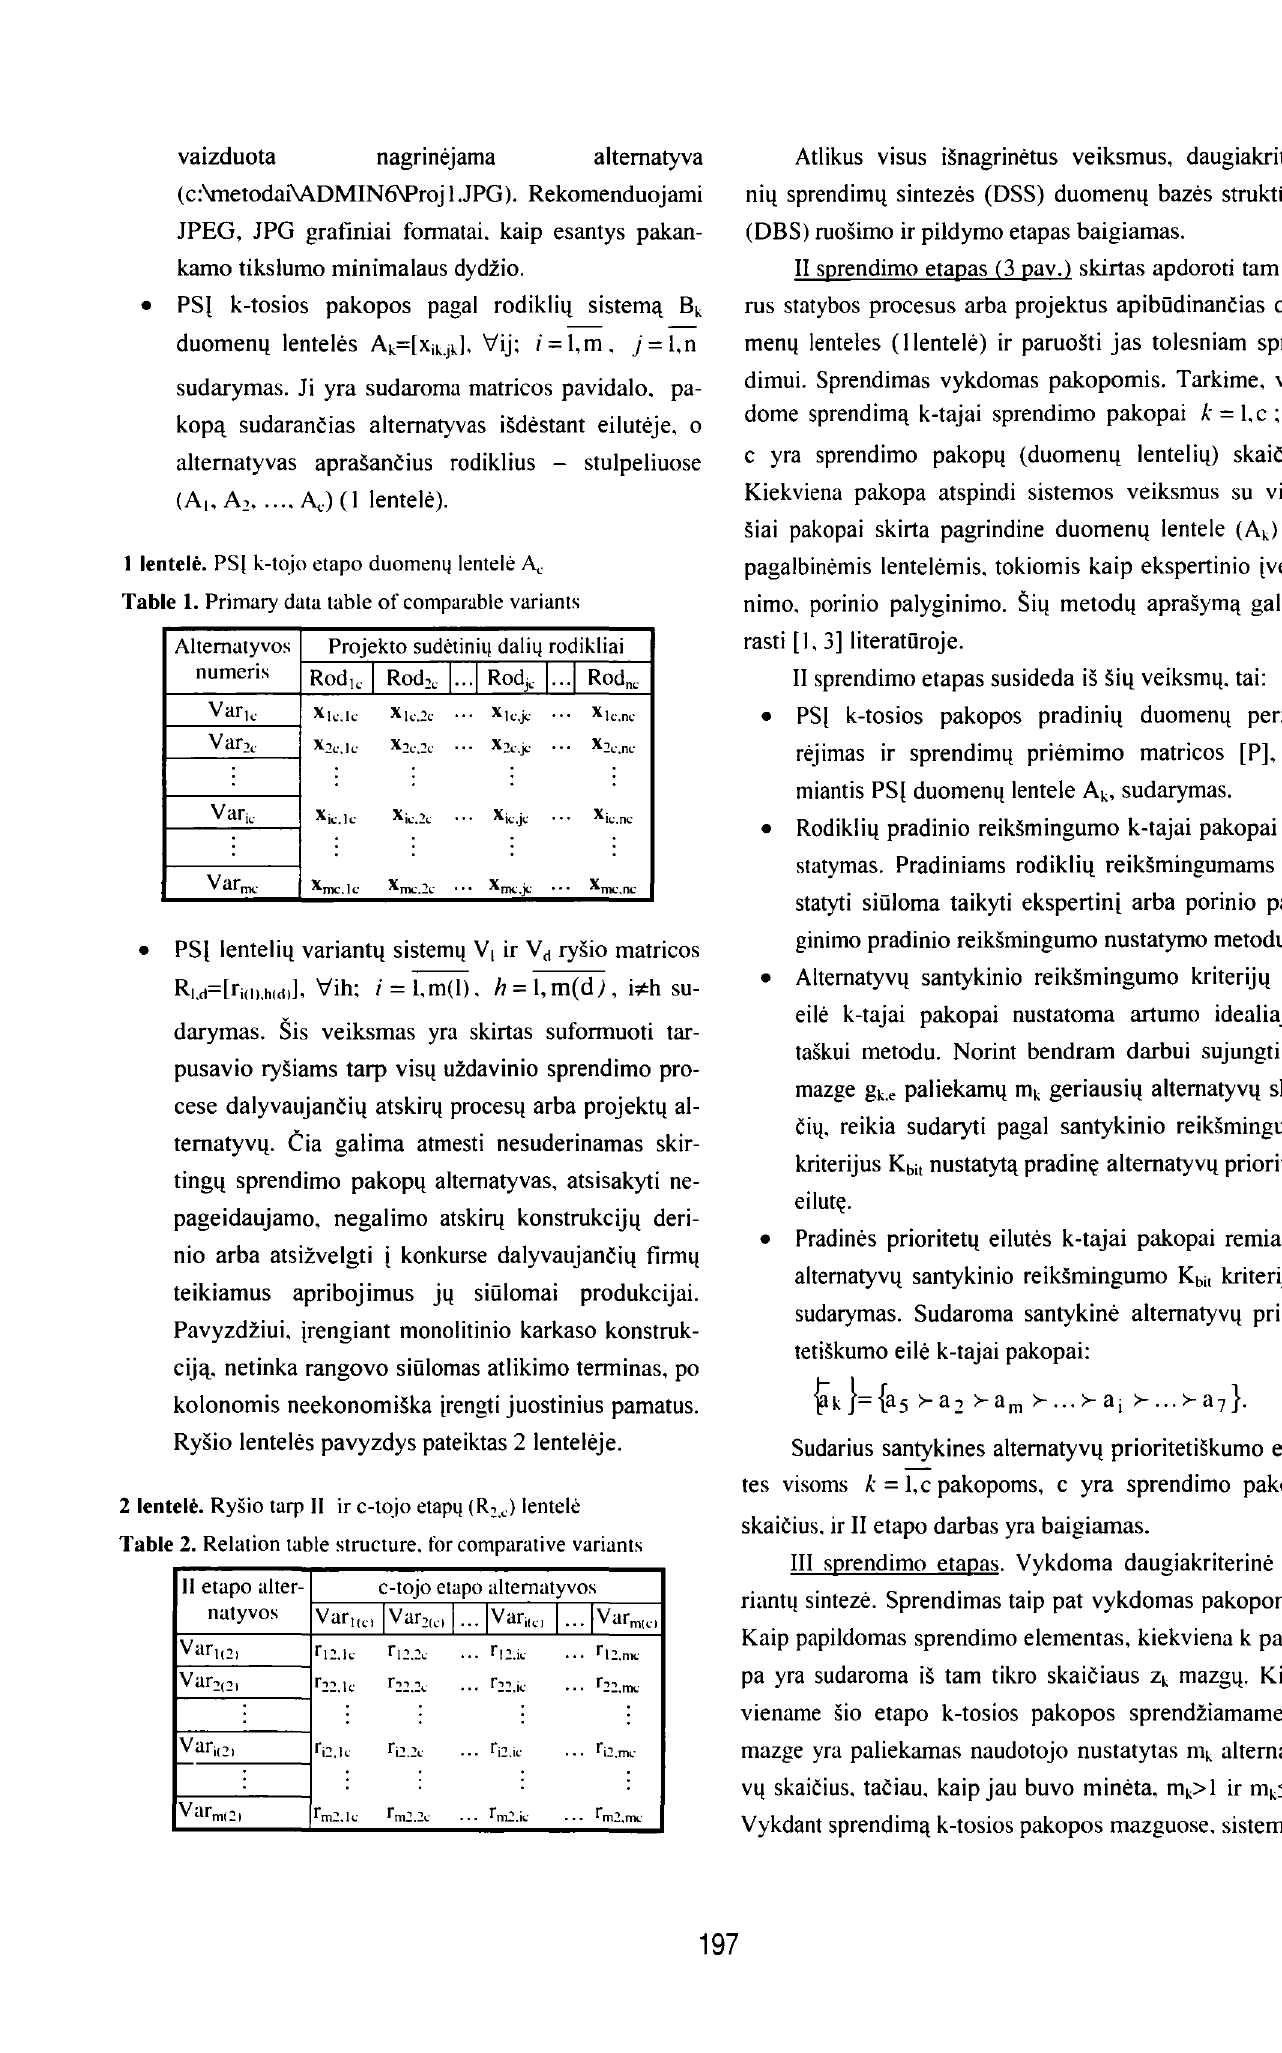
Table 2. Relation table structure. for comparative variants II etapo alter- c-tojo etapo altematyvos natyvos v ar21ei ... arilcJ ..